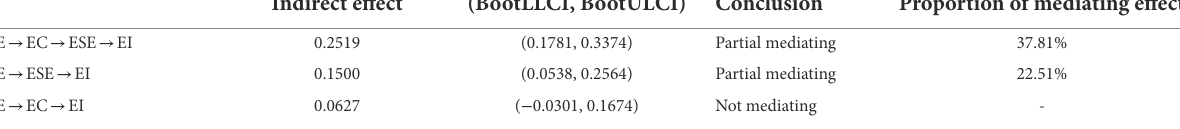
TABLE 6 Measuring mediation effects.